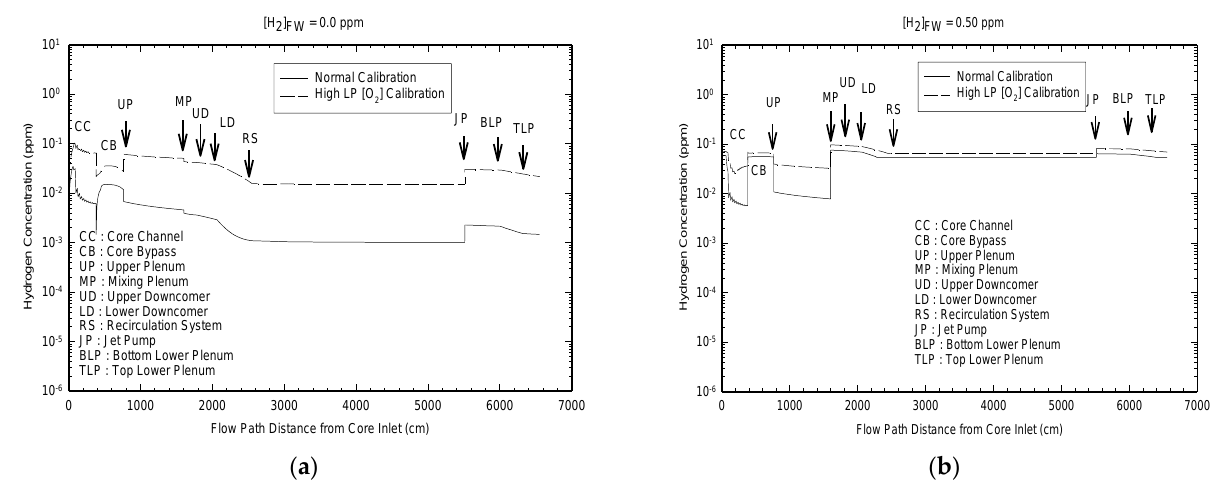
Figure 15. Calculated [H 2 ] around a BWR PHTS for ( a ) NWC and ( b ) HWC with [H 2 ] FW = 0.5 ppm. Note that two calibrations are included: the normal calibration on [O 2 ] in the autoclave valved into the recirculation system and calibration of the [O 2 ] measured in the LP [233]. The predicted hydrogen concentration around the coolant circuit is displayed in Figure 15. Concentrating on the normal calibration, we note that the [H 2 ] under NWC (no hydrogen added to the feedwater) ranges from about 30 ppb in the CCs and slightly lower in the core bypass (CB) down to 1 ppb in the recirculation system. This hydrogen is produced entirely by the radiolysis of water because no hydrogen is added to the feed